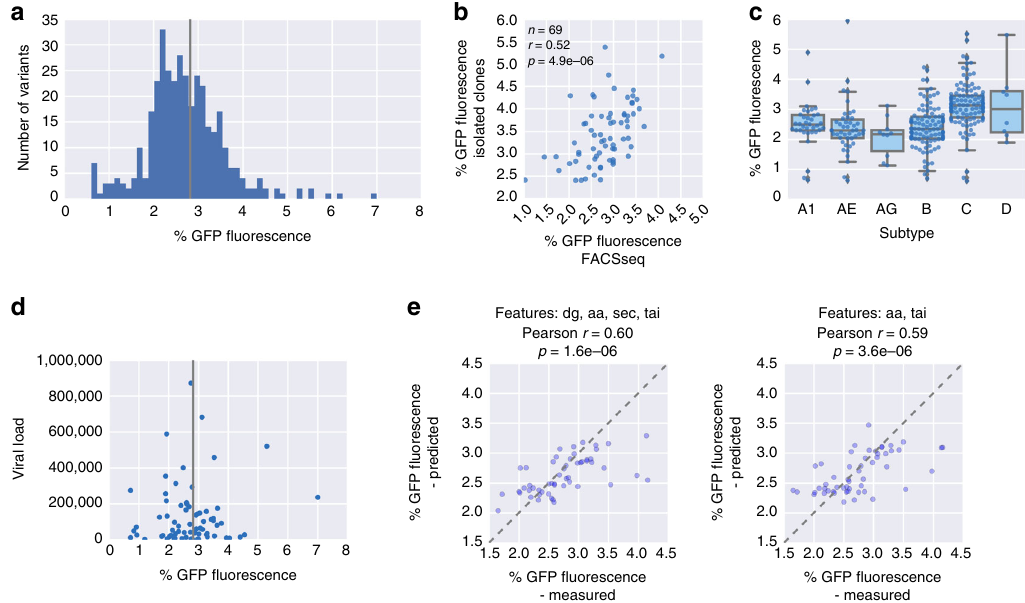
Fig. 7 Testing of PRF sites from HIV clinical isolates reveals subtype differences and associations with viral load. a Distribution of percent GFP fl uorescence of measured HIV variants, n = 368. b Percent GFP fl uorescence as determined by FACSseq is plotted against the value determined by measuring the corresponding isolated clone by FACS; Pearson correlation coef fi cient and the associated two-tailed p -value are reported. c Boxplot showing percent GFP fl uorescence of HIV gag-pol PRF variants coming from the indicated subtypes; the box shows the quartiles of the dataset, while the whiskers show the rest of the distribution except for outliers; n = 35, 46, 10, 103, 112, and 8 sequences tested, in the order they appear on the graph. d Viral load (HIV titer) is plotted against percent GFP fl uorescence determined for the natural gag-pol PRF site variant from the corresponding clinical isolate; vertical line: HIV HXB2 wild-type percent GFP fl uorescence, n = 77. e Predicted vs. measured percent GFP fl uorescence for 20% of the HIV variants (held-out test set) with the full feature set except for the identity of slippery site positions (left) or after removing MFE features (middle) or all secondary structure derived features (right) features: Pearson correlation coef fi cient and the associated two-tailed p -value are